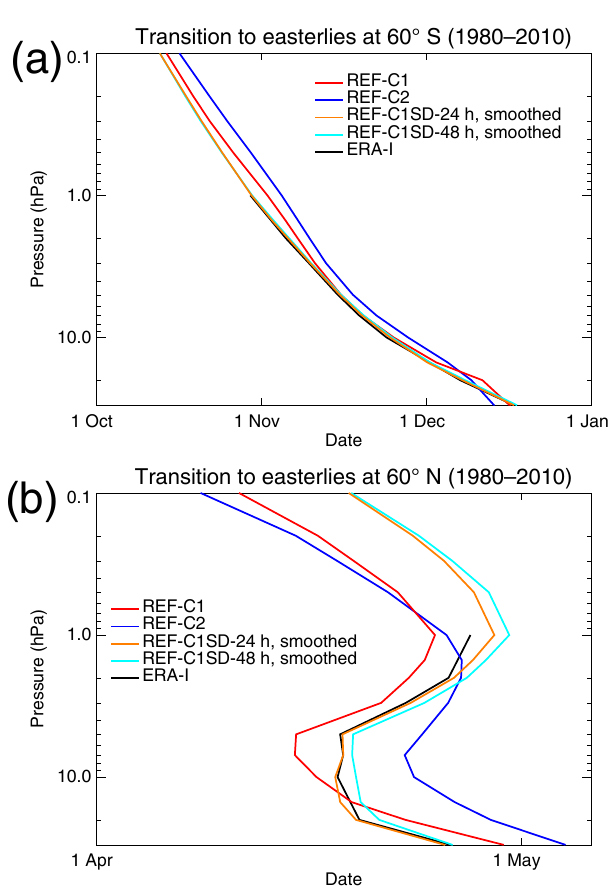
Figure 5. Polar vortex final warming times, as defined by the fi- nal transition from eastward to westward of the zonal-mean zonal wind at 60 ◦ , for (a) the Southern Hemisphere and (b) the Northern Hemisphere. Climatologies for the years 1980–2010 are